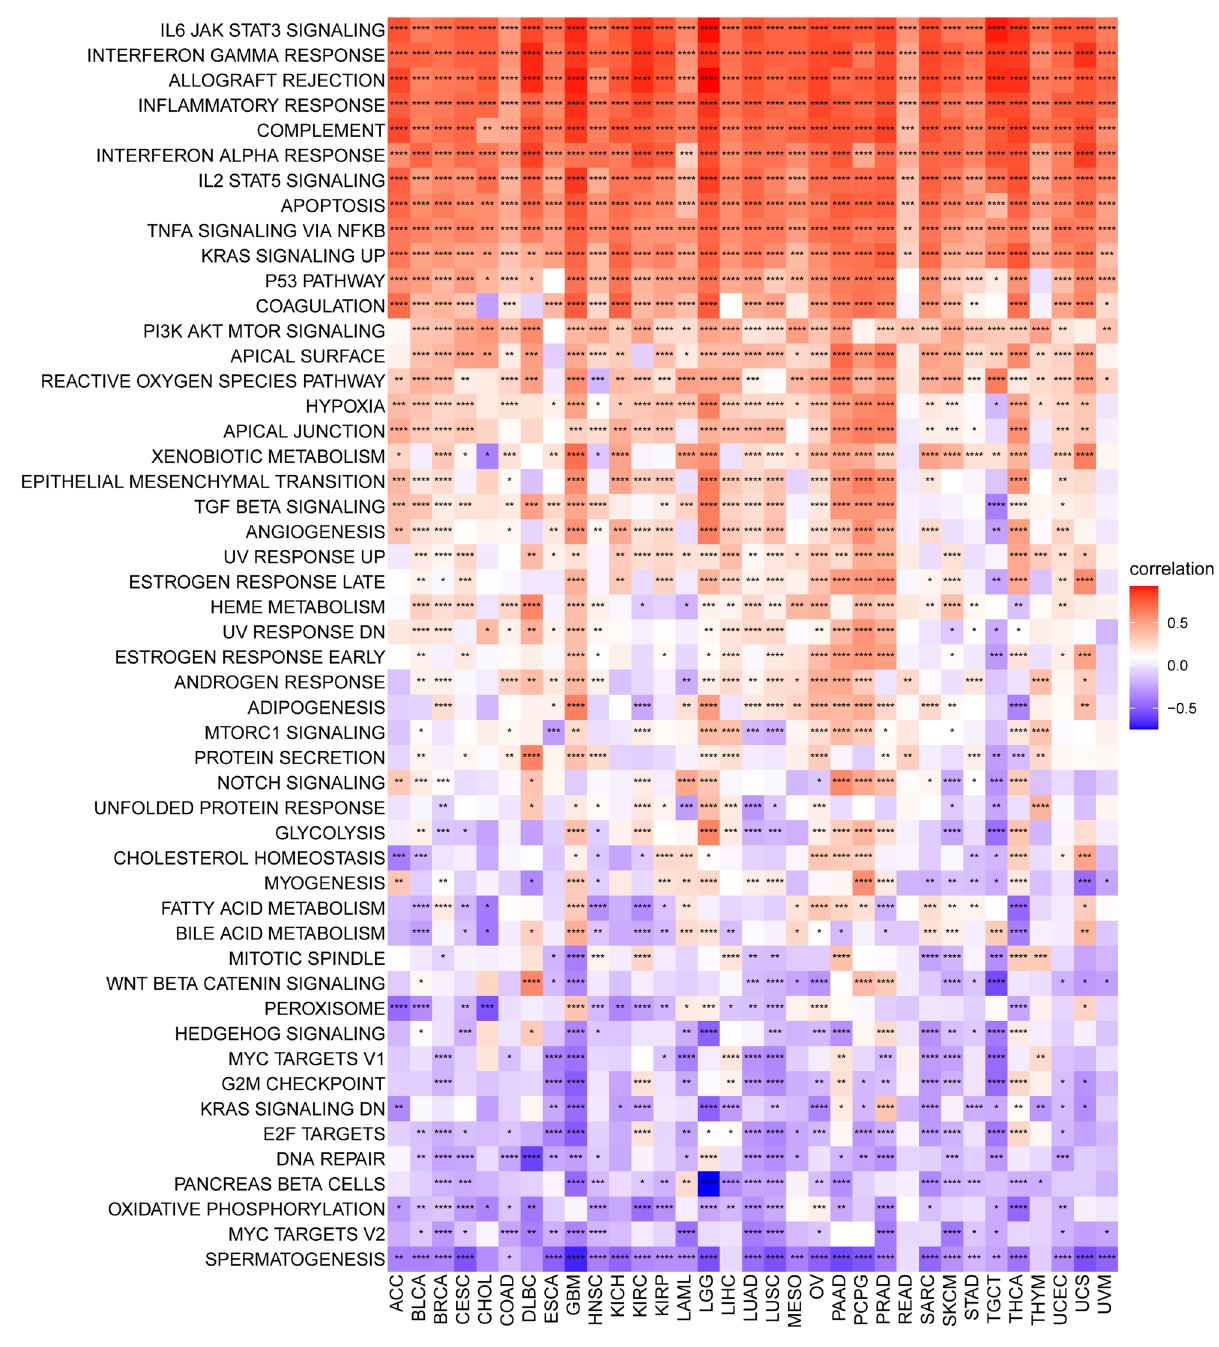
Figure 8. The correlation of PANoptosis score with HALLMARK pathways in